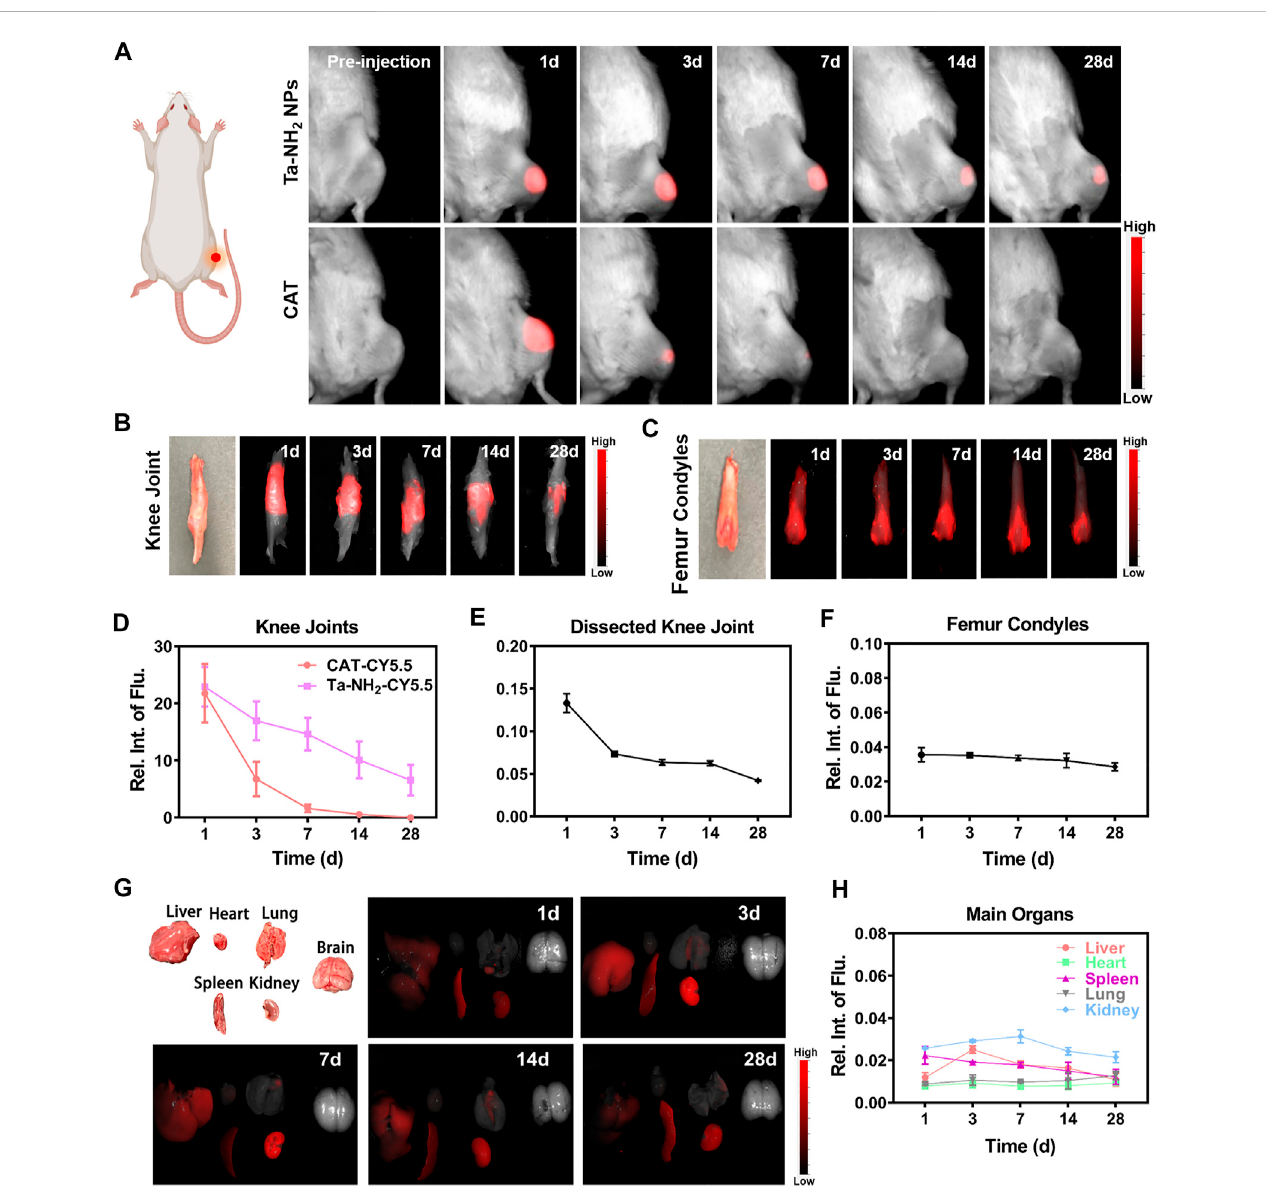
FIGURE 5 Metabolickinetics ofTa-NH 2 NPsinkneejoints andbiodistributioninmain organsofSD rats. Invivo fl uorescenceimagingofcy5.5-labelled Ta-NH 2 NPs andCATin (A) intact,cy5.5-labelledTa-NH 2 NPsin (B) dissectedratkneejoints,and (C) femoralcondylesfrom1to28 dayspostsingleintra-articularinjection. Fluorescence quanti fi cations of intact (D) and dissected (E) knee joints and femoral condyles (F) post intra-articular injection. (G) Biodistribution of Ta-NH 2 NPs and corresponding (H) fl uorescence quanti fi cation in major organs during 1 – 28 days post single intra-articular injection. Data were represented as means ± s.d., from three independent